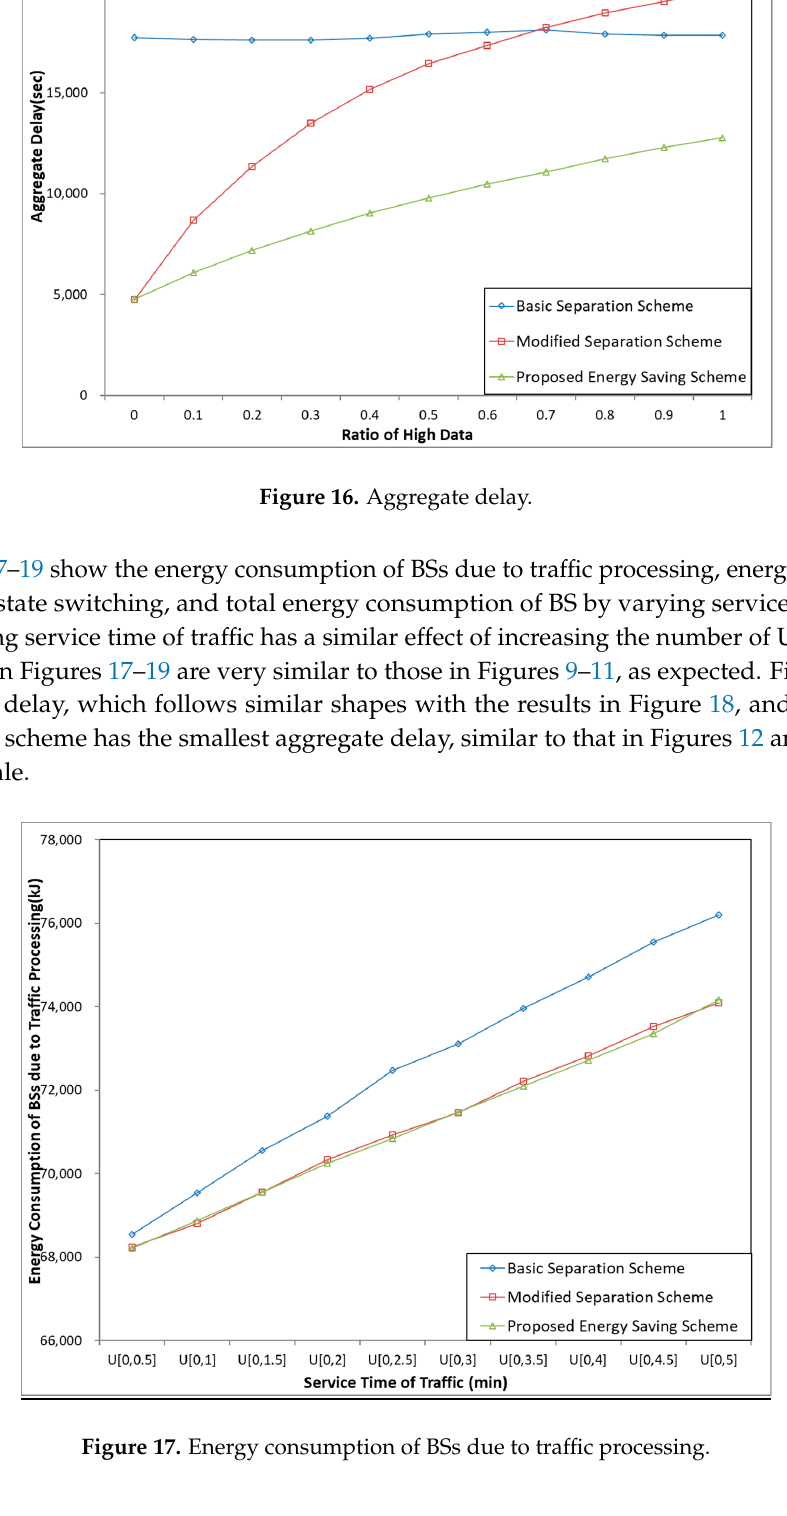
Figure 15. Total energy consumption of BSs.